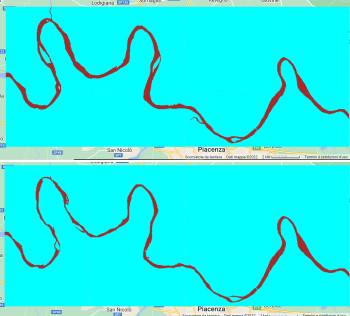
Figure 15. Water detection image on April-June 2020 (above) and on April-June 2022